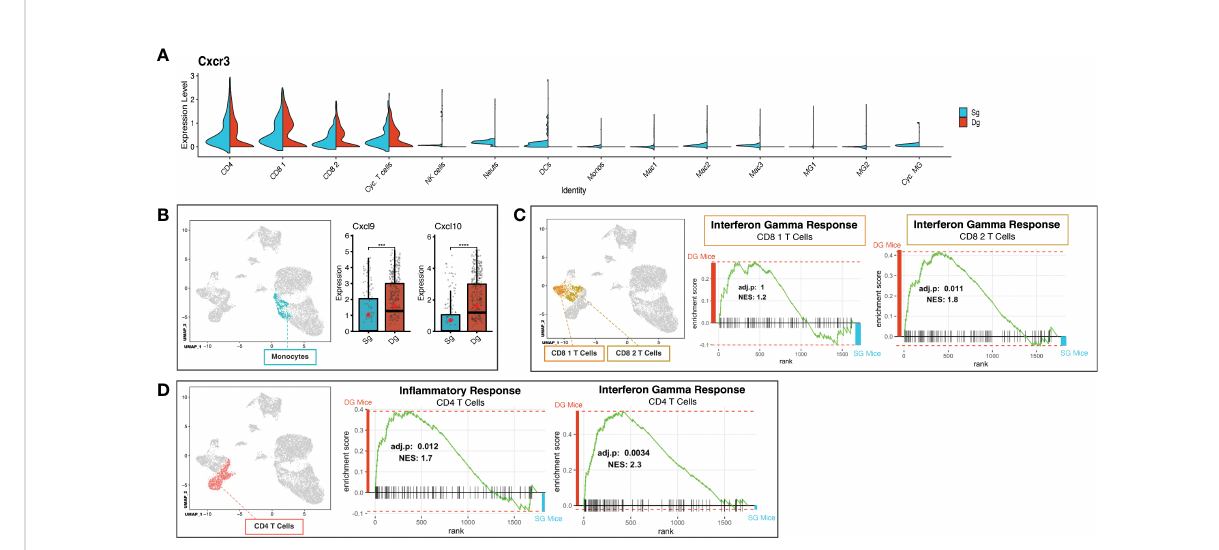
FIGURE 5 Neutrophil accumulation alters expression of T cell attractant chemokines and T cell activation state. (A) Split violin plot of scRNAseq data showing Cxcr3 expression level (y-axis) compared by cluster (x-axis) with width of plot signifying frequency of Cxcr3 expressing cells. Cxcr3 expression relegated to T cell cluster subsets (CD4, CD8 1, CD8 2, Cyc. T Cells) in both single-tg (blue) and double-tg (red) mouse datasets. (B) Expression levels of chemokines Cxcl10 and Cxcl9 in monocytes are shown for single-tg (blue) and double-tg (red) mouse datasets. (C) Gene set enrichment analysis (GSEA) for IFN- g responses in CD8 1 T cell and CD8 2 T cell clusters from spinal cord of single-tg (n = 4) and double-tg mice (n = 4) at day12 p.i. Responses to IFN- g were enriched in both populations of double-tg CD8 T cells compared to control single-tg mice. (D) GSEA plot for in fl ammatory response and IFN- g response in CD4 T cells. Responses to both in fl ammatory response and IFN- g response was enriched in the CD4 T cell population of double-tg mice compared to control single-tg mice. The GSEA plots correspond to the designated Hallmark In fl ammatory Response and Hallmark Interferon Gamma Response gene sets established in the Molecular Signatures Database (MSigDB) (45, 46). *** p < 0.001; **** p <